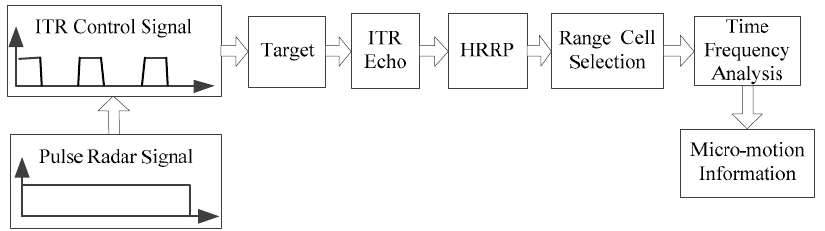
Figure 3. Procedure of micro-motion feature extraction for rotating target.